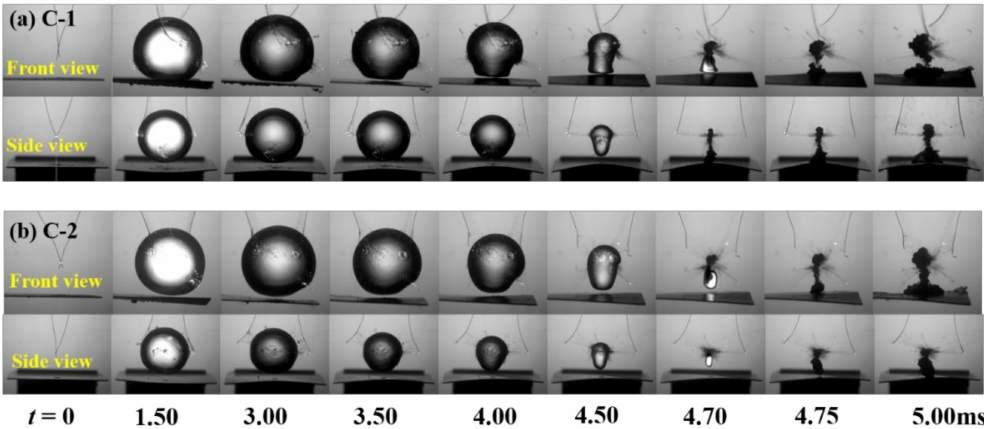
Figure 4. Front view and side view of the transient evolution of the bubble near ( a ) C-1 and ( b ) C-2 plates ( γ =